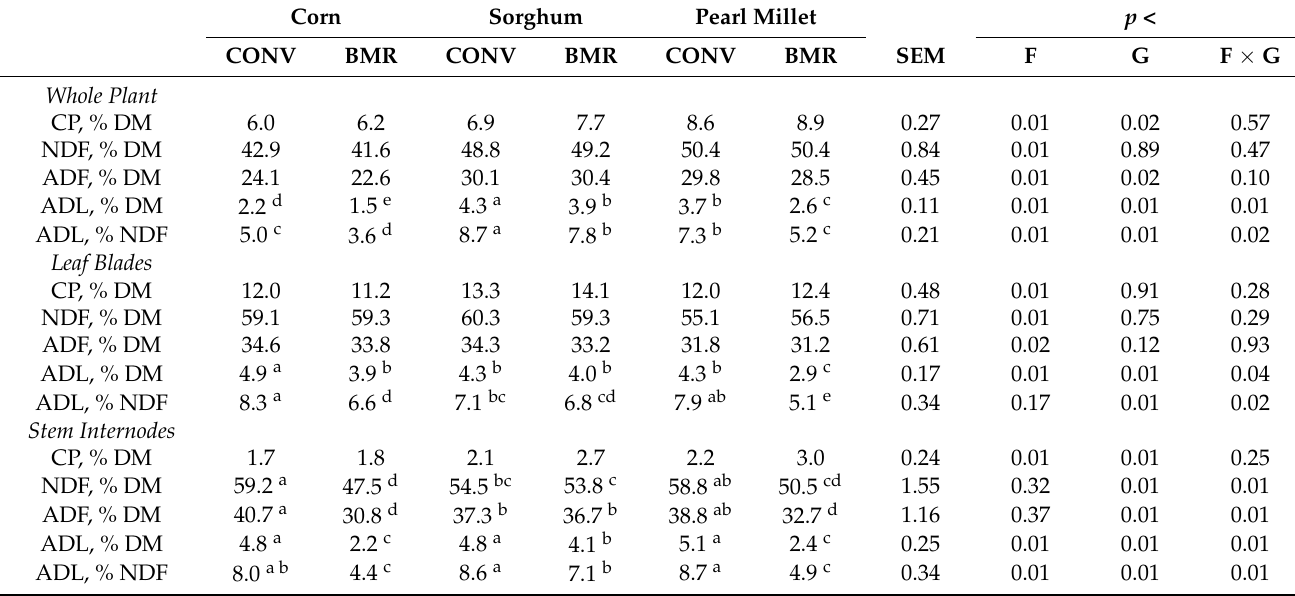
Table 1. Nutritional composition † of whole plants and plant tissues of warm-season annual grasses of different forage types (F) and genotypes ‡ (G). Corn Sorghum Pearl